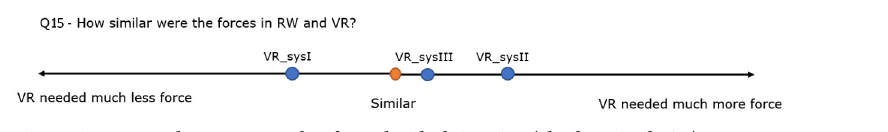
Fig 9. Distances each system score has from the ideal situation (absolute